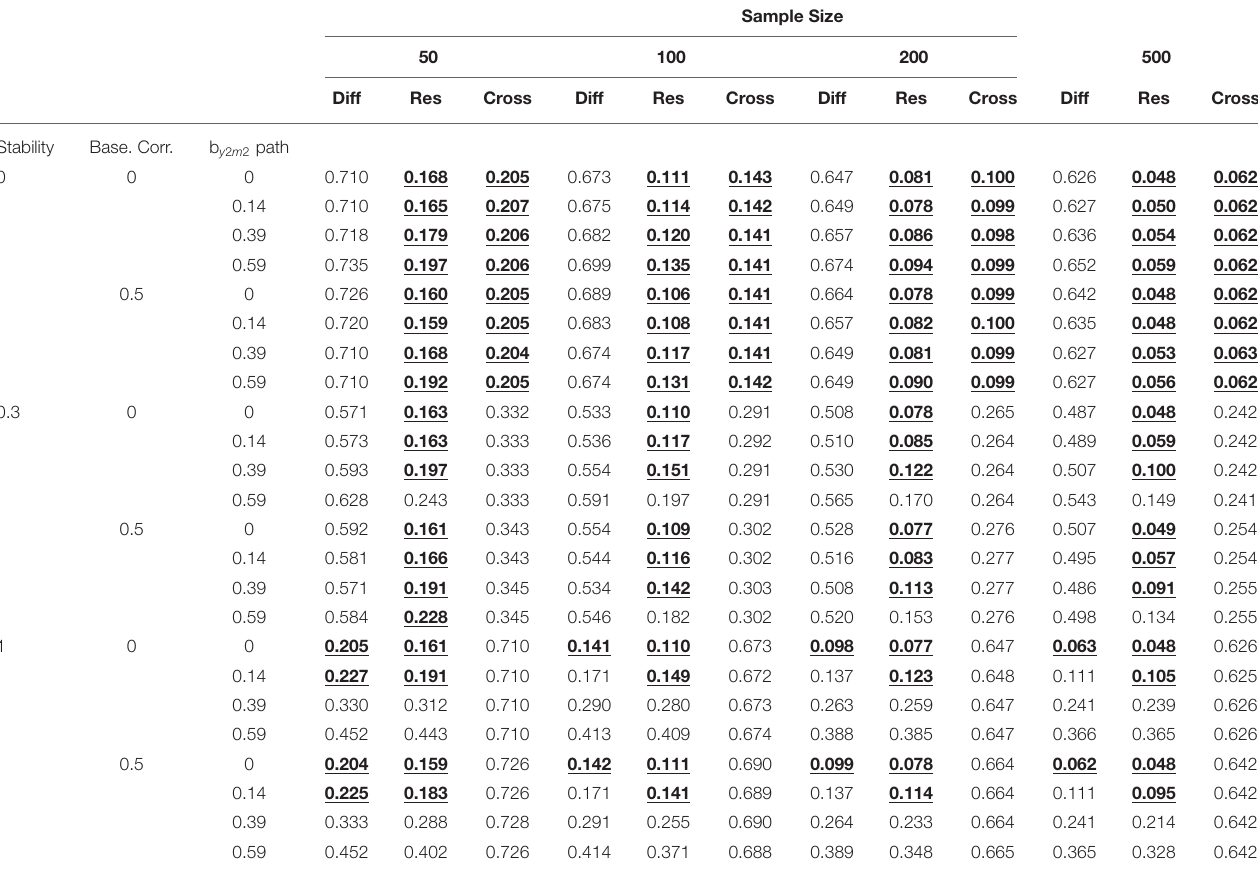
TABLE 4 | T -size RMSEA values (RMSEA_t) for the difference score model (Diff), residualized change score model (Res), and cross-sectional model (Cross) for M 2 cross-lag = 0 and Y 2 cross-lag = 0.